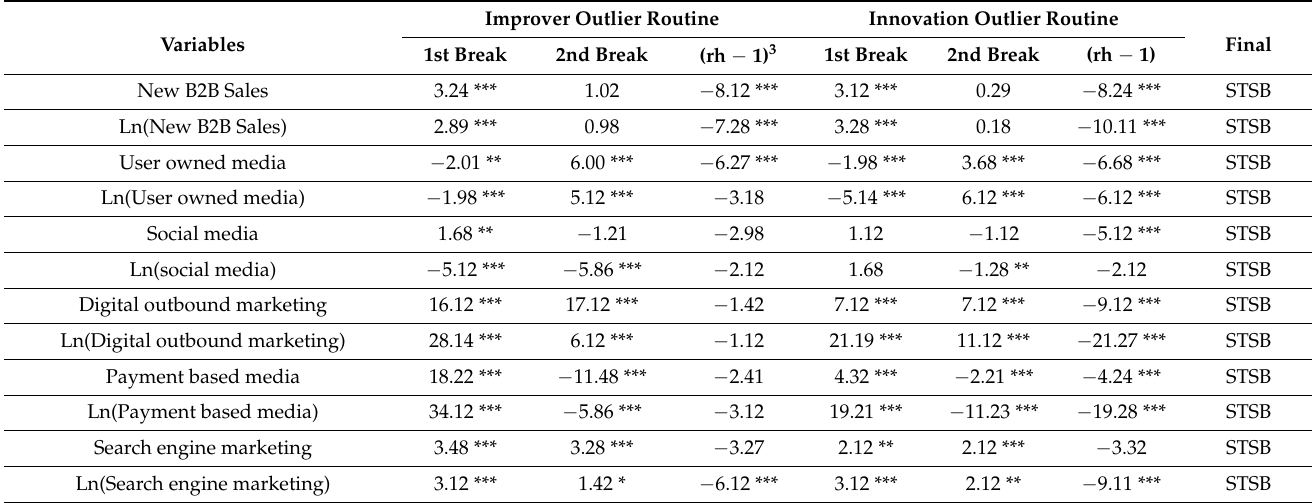
Table A3. Unit roots and structural break routines on model